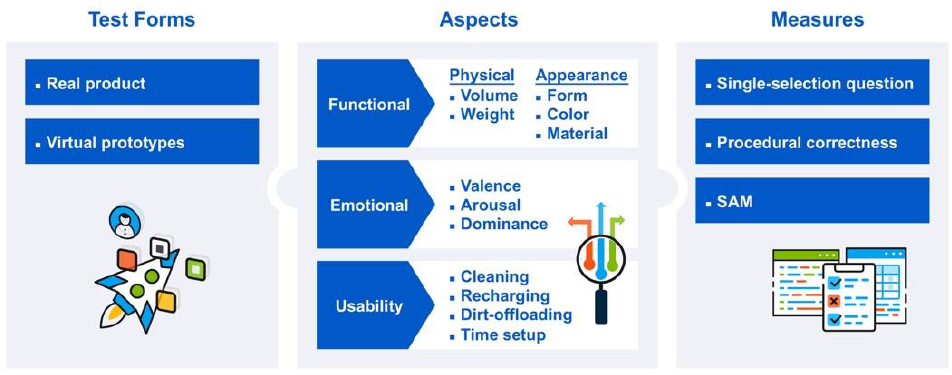
Figure 2. Systematic design of experiments.